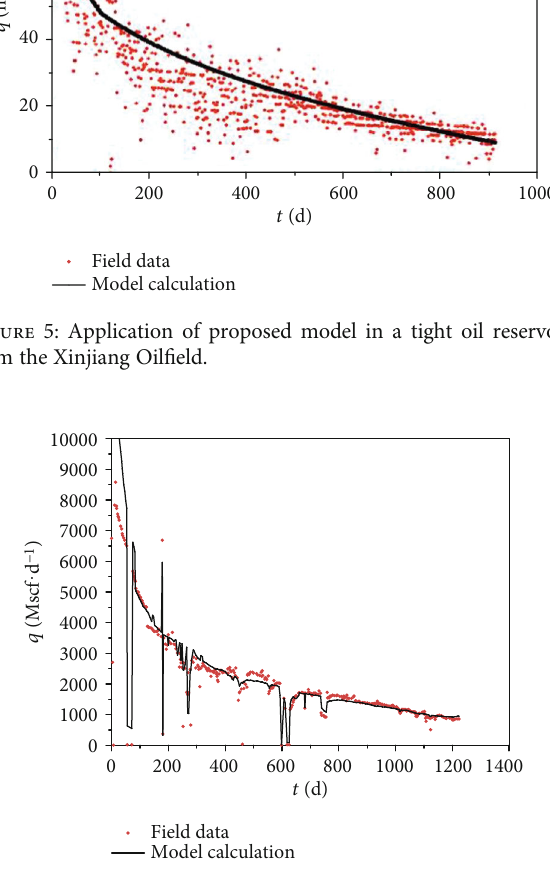
Figure 6: Application of proposed model in a shale gas reservoir from Barnett